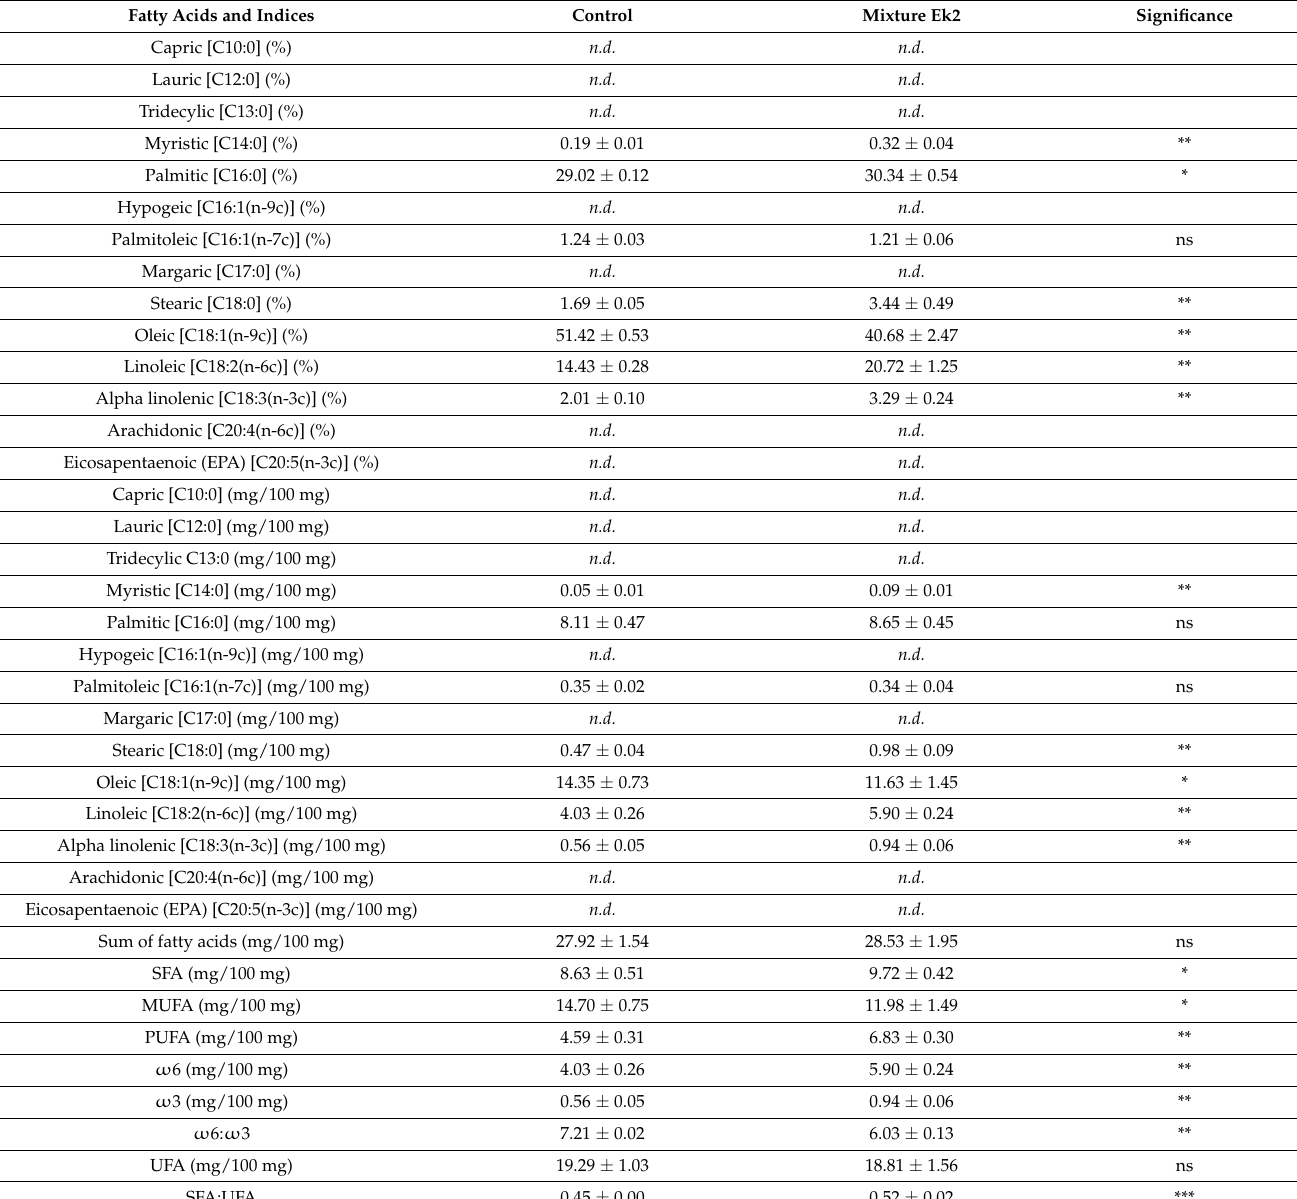
Table 4. Percentages and concentration (means ± standard deviation) of fatty acids in E. kuehniella larvae as a function of the diet. Results are expressed per dry matter (DM).